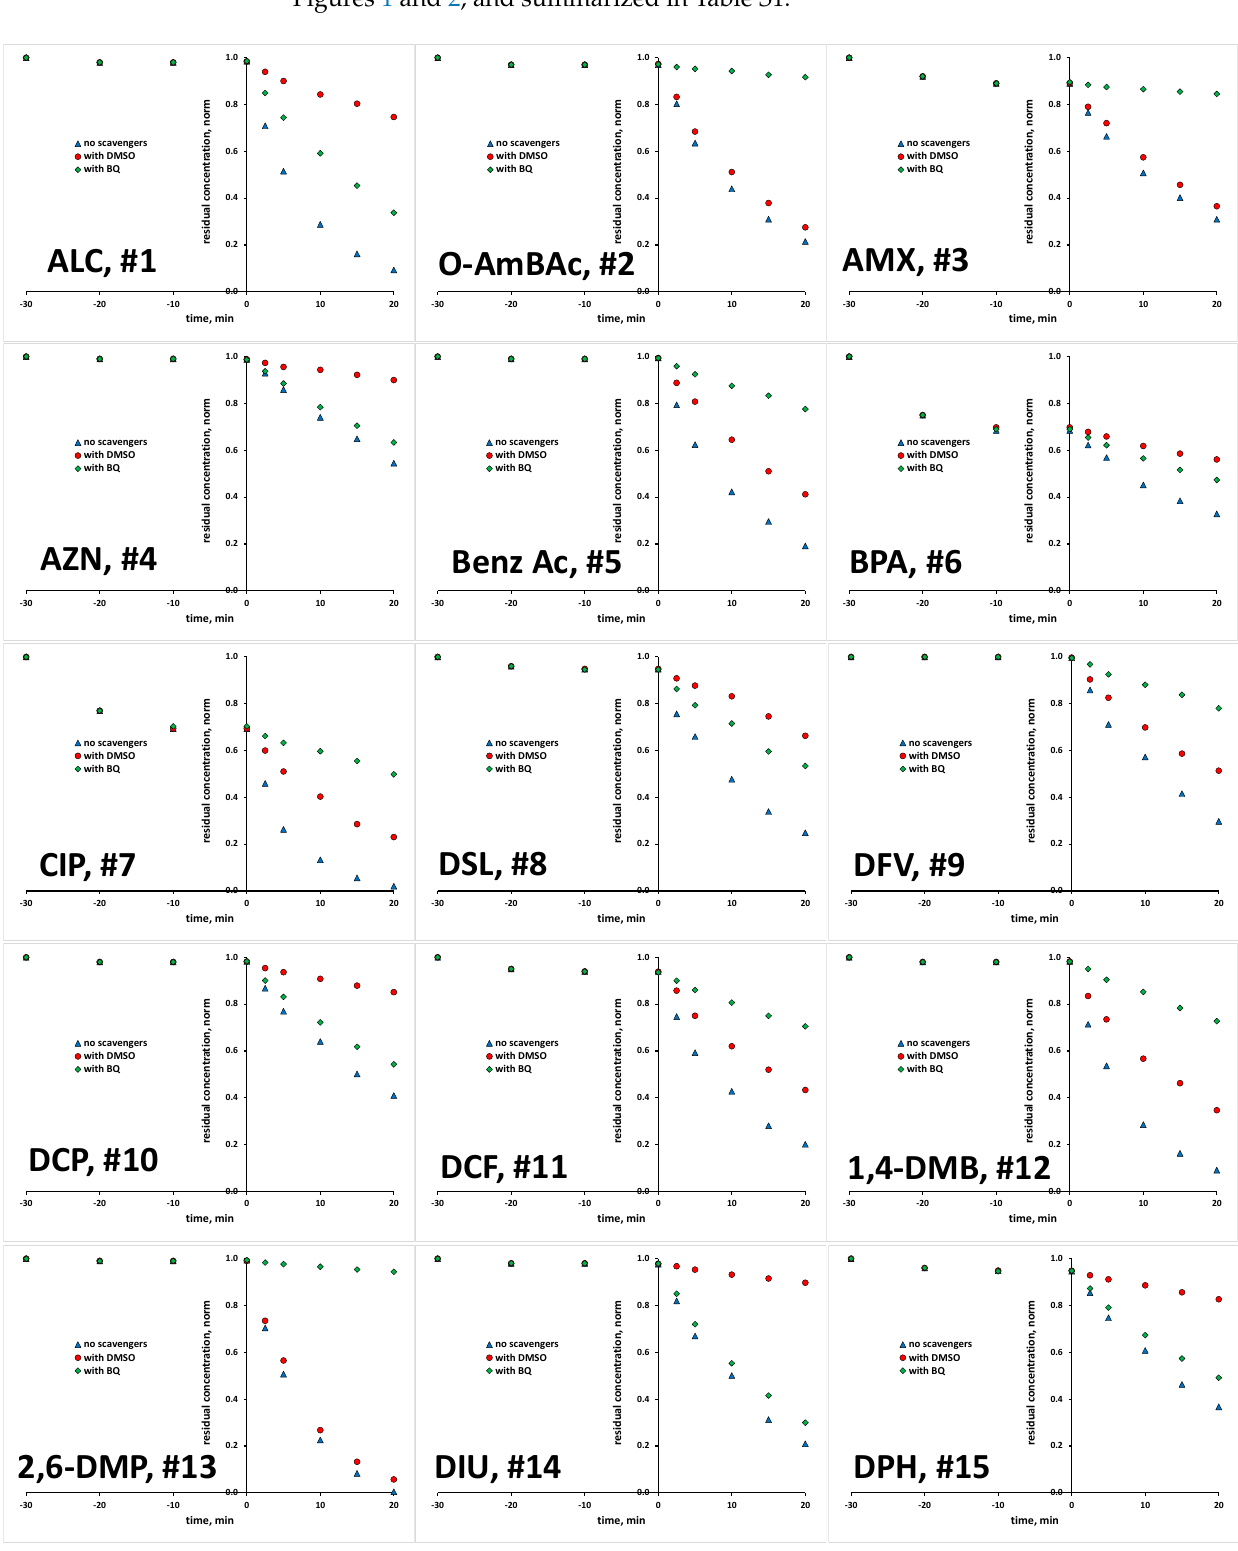
Figure 1. Degradation kinetics of studied organics (#1–15, Table 1) without and with the presence of scavengers for HO• and O 2 • − .